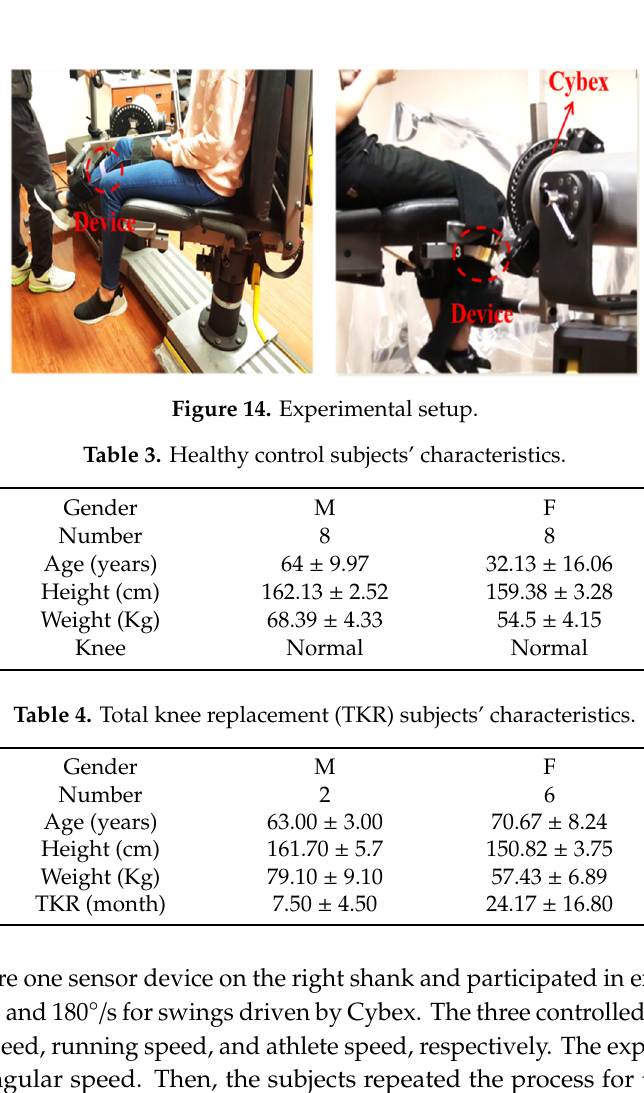
12 of 18 Table 3. Healthy control subjects’ characteristics. Gender Normal Table 4. Total knee replacement (TKR) subjects’ characteristics. Gender